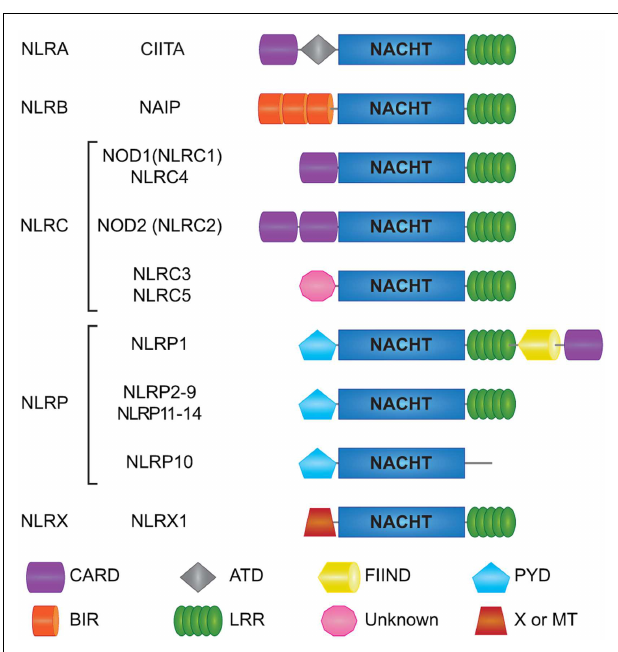
FIGURE 1 | Schematic representation of individual NLR domains . Domain architecture of human NLRs is depicted here. Human NLRs are sub-classified into five categories: NLRA, NLRB, NLRC, NLRP, and NLRX. All 22 human NLRs contain a central NACHT domain and a C-terminal ligand sensing LRR domain, with the exception of NLRP10.The N-terminal domains ascribe functional properties to the NLRs; however, the function of some of the domains is still unclear like for the N-terminal domain of NLRC3 and NLRC5, as well as the C-terminal FIIND in NLRP1. CARD; caspase association and recruitment domain, ATD; acidic transactivation domain, FIIND; function to find domain, PYD; pyrin domain, BIR; Baculoviral inhibition of apoptosis protein repeat domain, LRR; leucine-rich repeats, MT; targets NLRX1 to the mitochondria but no sequence homology with traditional mitochondrial targeting sequence has been